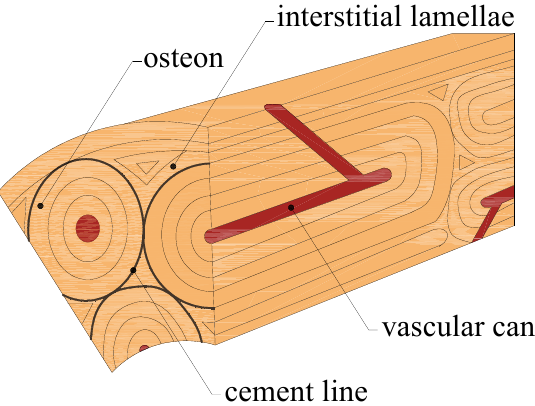
Figure 1: Cortical bone microstructure level.